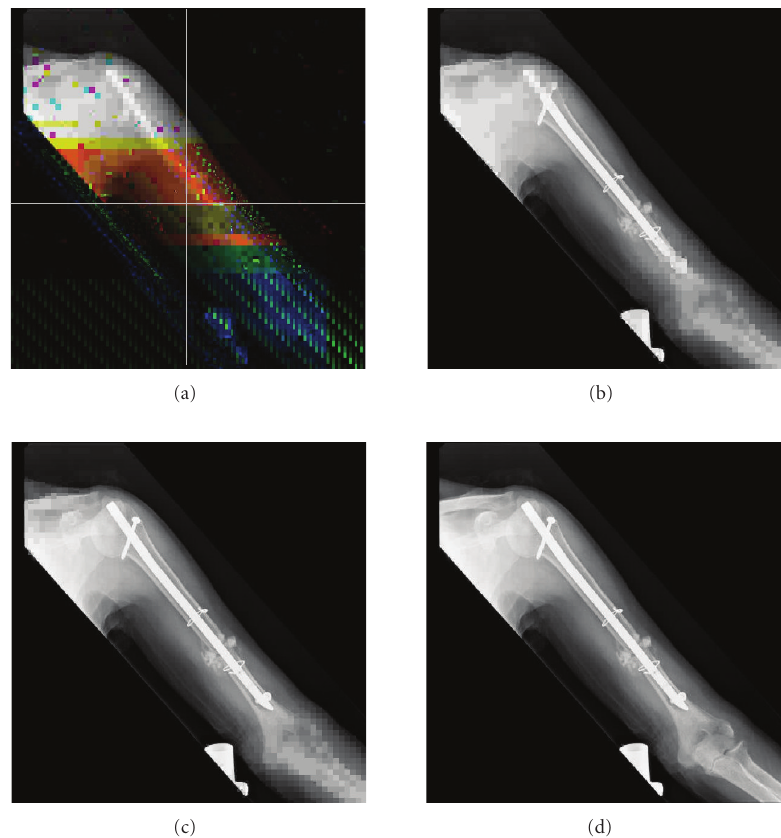
Figure 14: As another example, a decoded image with variable length parity, which is a 508 × 512 pixels monochrome X-ray bone image: (a) a background image and the location of RoI selected in the center of image reconstructed after stage P 1 ; many subblocks are in error in the background image, (b) the reconstructed image after stage P 2 , no error subblock is found in the reconstructed image. (c) The reconstructed image after stage P 3 , and (d) the complete transmitted image having no error